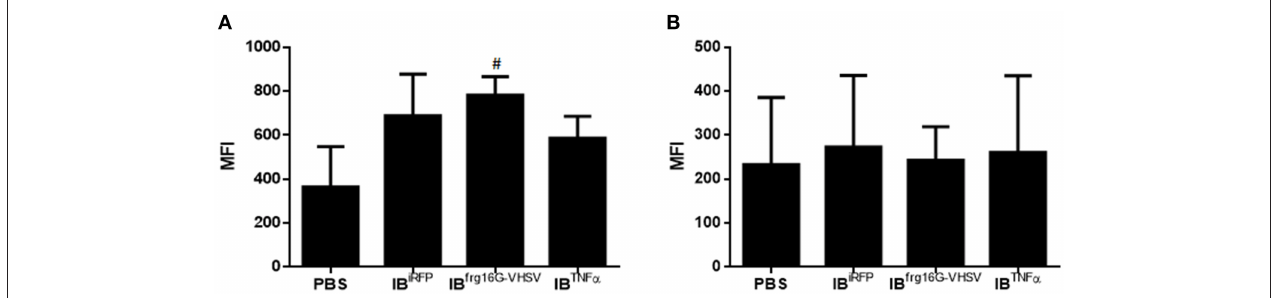
FIGURE 8 | Protein expression analysis of total blood samples from rainbow trout injected intravenously with 5.5 mg/kg of IB iRFP , IB TNF α , IB frg16G − VHSV , and PBS at 48h post-injection. (A) Interferon related protein MX and (B) chemokine IL8 Mean Fluorescence Intensity (MFI) measured by flow cytometry. Data represent mean ± SD ( n = 4). Mann-Whitney test was performed between each condition and control cells (treated with PBS or IB iRFP ). # P -value < 0.05, compared to PBS.